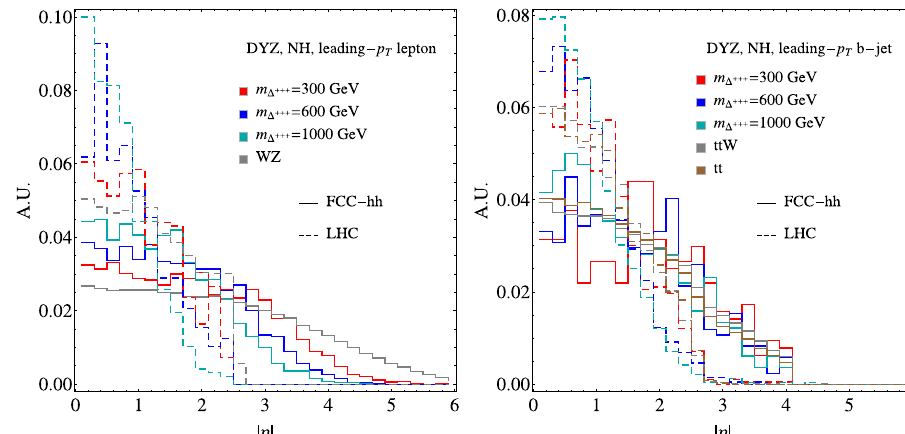
Fig. 12 The normalized distributions of the rapidity | η | in the DYZ process for the NH and m (cid:2) ±±± = 300, 600 and 1000 GeV and backgrounds. | η | for the leading p T lepton and b -jet for the left and right panels,